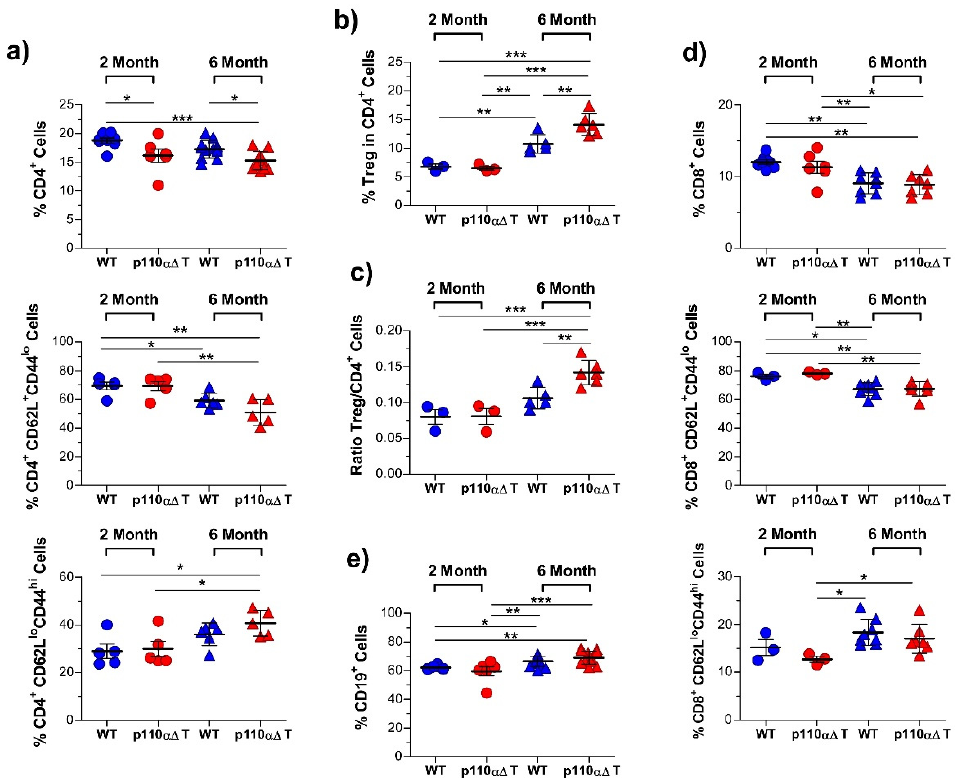
Figure 1. Flow cytometry analysis of spleen cell lymphocyte subpopulations in young, 2 month-old, or mature, 6 month-old wild type (WT) and p110 αΔ T mice. ( a ) Percentage of CD4 + T cells (top), naïve CD4 + T cells (CD62L + CD44 lo , middle), and effector/memory CD4 + T cells (CD62L lo CD44 hi , bottom) in young (circles), or mature mice (triangles). ( b ) Percentage of regulatory T cells (Treg, CD25 + Foxp3 + in CD4 + T cells). ( c ) Ratio of Treg to conventional, non-Treg Foxp3 − CD4 + T cells. ( d ) Percentage of CD8 + T cells (top), naïve CD8 + T cells (CD62L + CD44 lo , middle), and effector/memory CD8 + T cells (CD62L lo CD44 hi , bottom). ( e ) Percentage of CD19 + cells (B cells). Data from individual WT (blue symbols) or p110 αΔ T mice (red symbols), as well as the mean ± SEM for each group, are depicted. Only significant differences between groups are indicated, as determined by one-way ANOVA (* p < 0.05, ** p < 0.01, *** p < 0.001). WT 2 month, n = 8 (( a ) top, ( d ) top, ( e )); n = 5 (( a ) middle, ( a ) bottom); n = 3 (( b ), ( c ), ( d ) middle, ( d ) bottom). p110 αΔ T 2 month, n = 6 (( a ) top, ( d ) top, ( e )); n = 5 (( a ) middle, ( a ) bottom); n = 3 ( b ), ( c ), ( d ) middle, ( d ) bottom). WT 6 month, n = 12 ( a ) top, ( e )); n = 8 ( d ) top, ( d ) middle, ( d ) bottom), n = 6 ( a ) middle, ( a ) bottom); n = 5 ( b ), ( c )). p110 αΔ T 6 month, n = 11 ( a ) top, ( e )); n = 7 ( d ) top, ( d ) middle, ( d ) bottom), n = 6 ( b ), ( c )); n = 5 ( a ) middle, ( a ) bottom). Figure 1b,c show that CD4 + Treg cells CD4 + were clearly higher in older mice, consid- ering either the percentage of Treg cells in CD4 + T lymphocytes or the ratio of Treg to CD4 + T cells. Besides, the proportion of Treg cells was significantly enhanced in six month-old p110 α ∆ T mice as compared to WT mice (Figure 1b,c). This might reflect the importance of the PI3-K p110 δ subunit in Treg numbers and function [34,39], as p110 δ is the main PI3-K subunit remaining in p110 α -deficient T cells